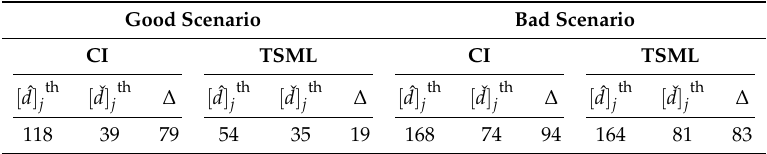
th , expressed in mm, such that P ([ ˆ d ] j < [ ˆ d ] j Table 4. Values of [ ˆ d ] j th of [ ˇ d ] j , expressed in mm, such that P ([ ˇ d ] j < [ ˇ d ] j ∆ = (columns 3, 6, 9, 12) are shown for different scenarios and